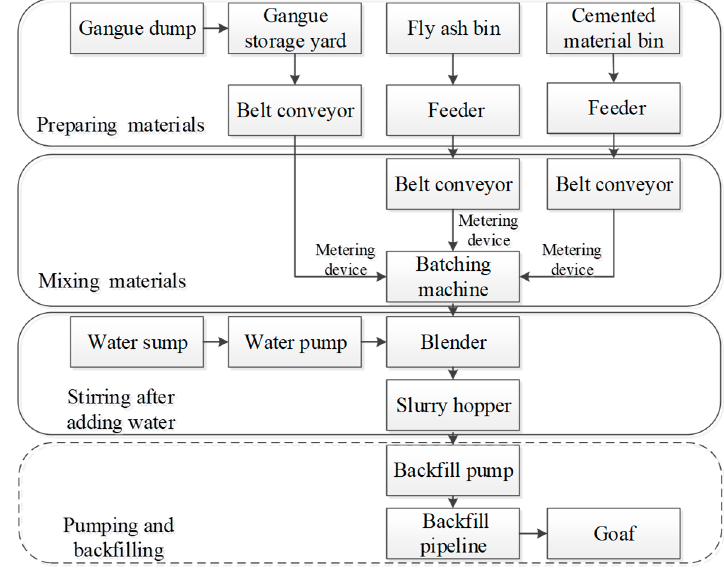
Figure 10. Backfilling process of cemented backfill materials.